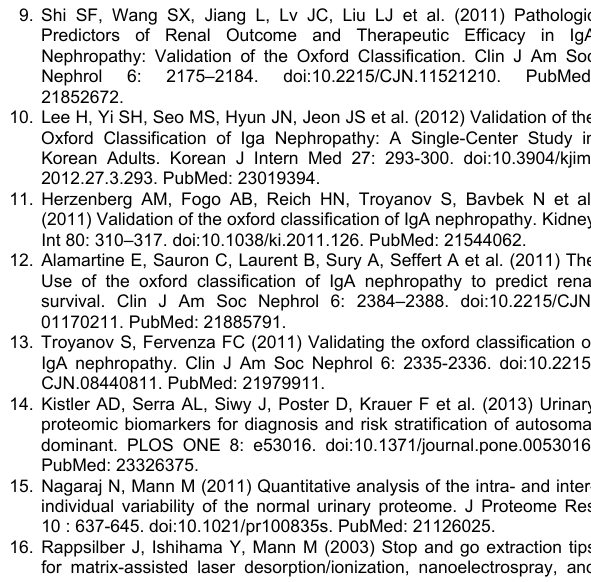
Table S6. Master molecules obtained from upstream regulator analysis for under-represented proteins.